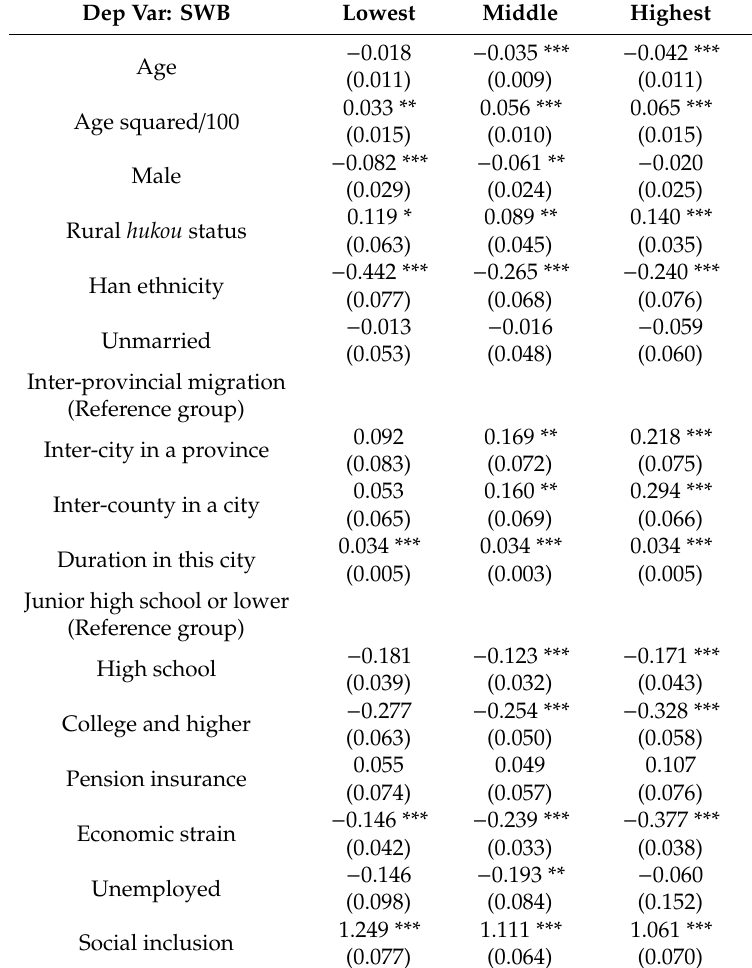
Table A2. The results of the omitted controls in Table